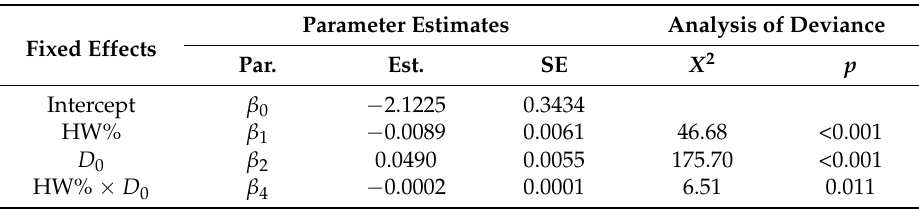
Figure 3. Average annual balsam fir defoliation (± one standard error) from 2012 to 2016, for nine plots in each of three stand types with varied hardwood contents, near Amqui, Quebec. Different letters indicate significant differences among stand types in each year. Table 2. Results of generalized linear mixed-effects model to test the effects of percent hardwood content (HW%) and average annual defoliation in softwood plots ( D 0 ) on defoliation for 27 plots from 2012 to 2016 in